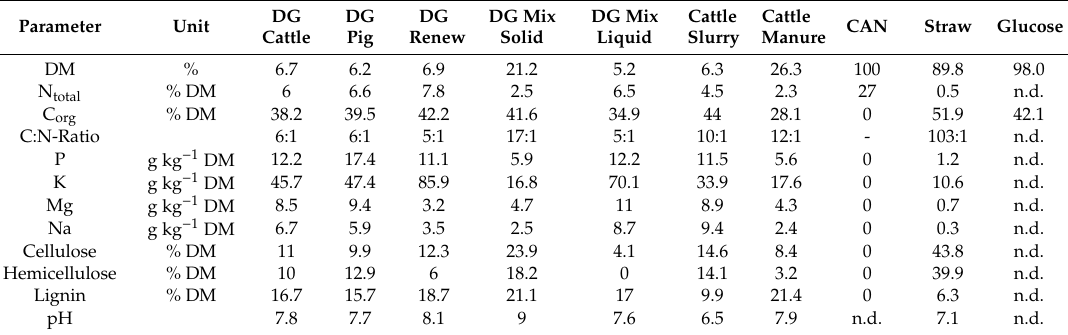
Table 3. Selected chemical parameters of the substrates used for the dehydrogenase measurements in the laboratory and for the soil respiration experiment. “n.d.” = not